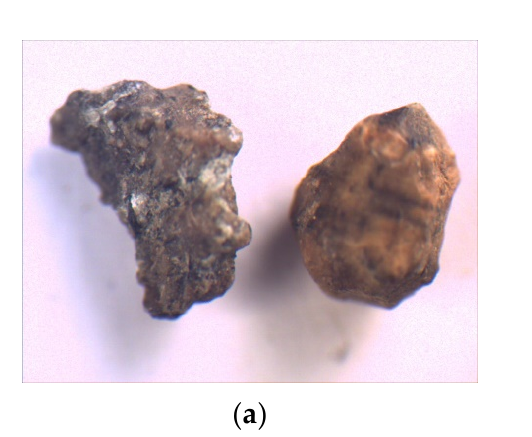
The cone slump and the cone flow of all the presented compositions of the concrete mixes reach satisfactory values. However, it should be noted that adding magnesium– silicate aggregates reduces their fluidity. It is influenced by the size and shape of aggregates (Figure 7).